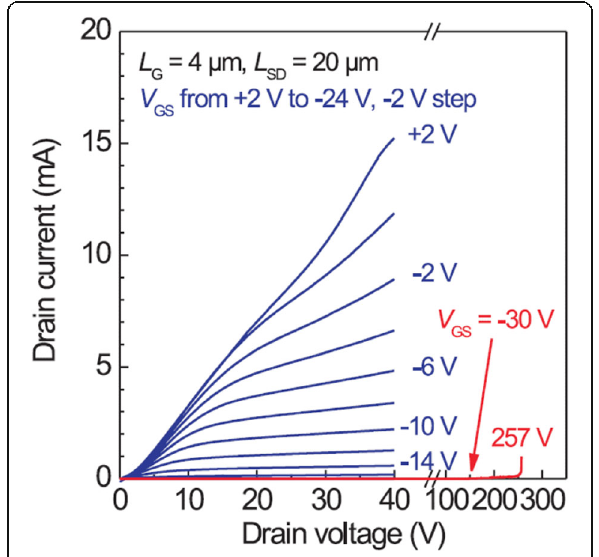
Fig. 6 Output characteristics of the SOG S/D-doped MOSFET with L μ m, drain gate spacing L μ m. Reproduced from Ref. g =8 gd =10